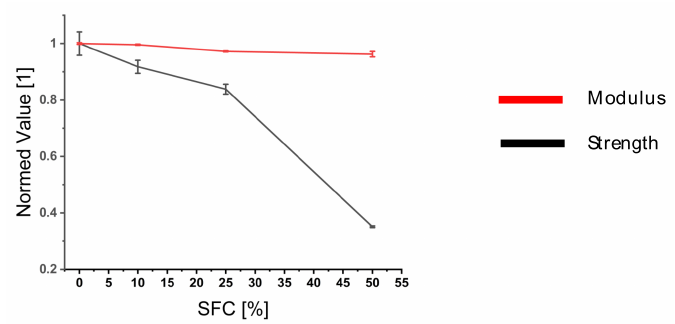
Figure 17. Parameter study of short fiber content influence on composite